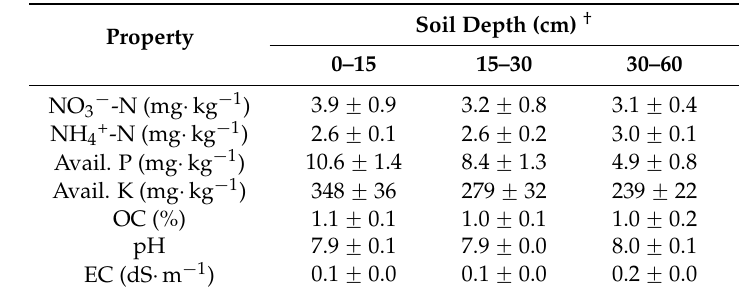
Table 1. Selected soil properties at the beginning of the field study in spring 2009 at three soil depth increments (0–15, 15–30 and 30–60 cm).